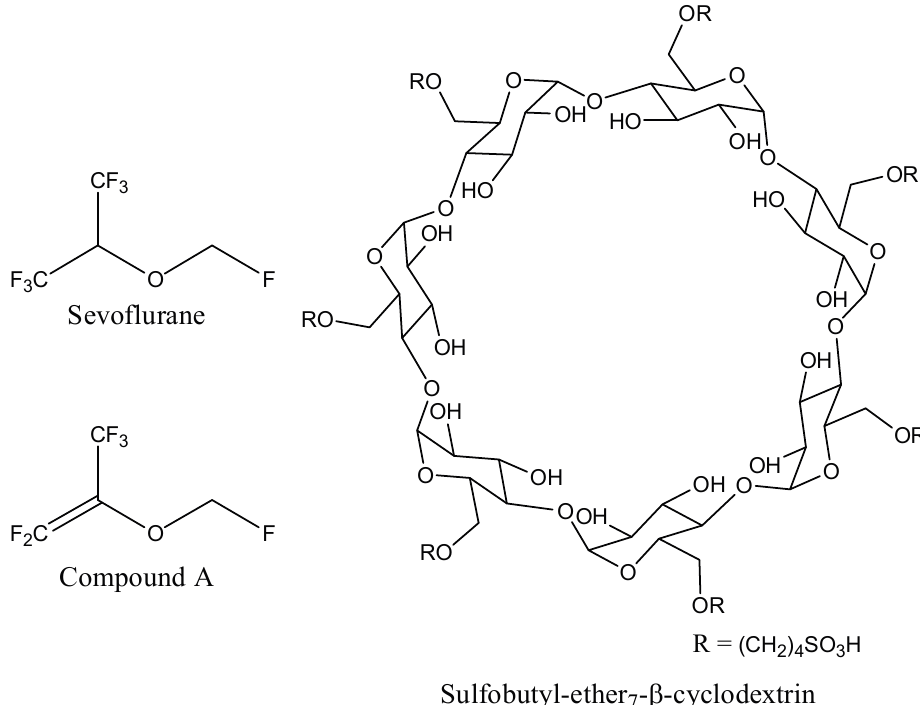
Figure 8. Schematic representations of sevoflurane, compound A, and sulfobutyl-ether 7 - β - cyclodextrin (SBE 7 β CD)